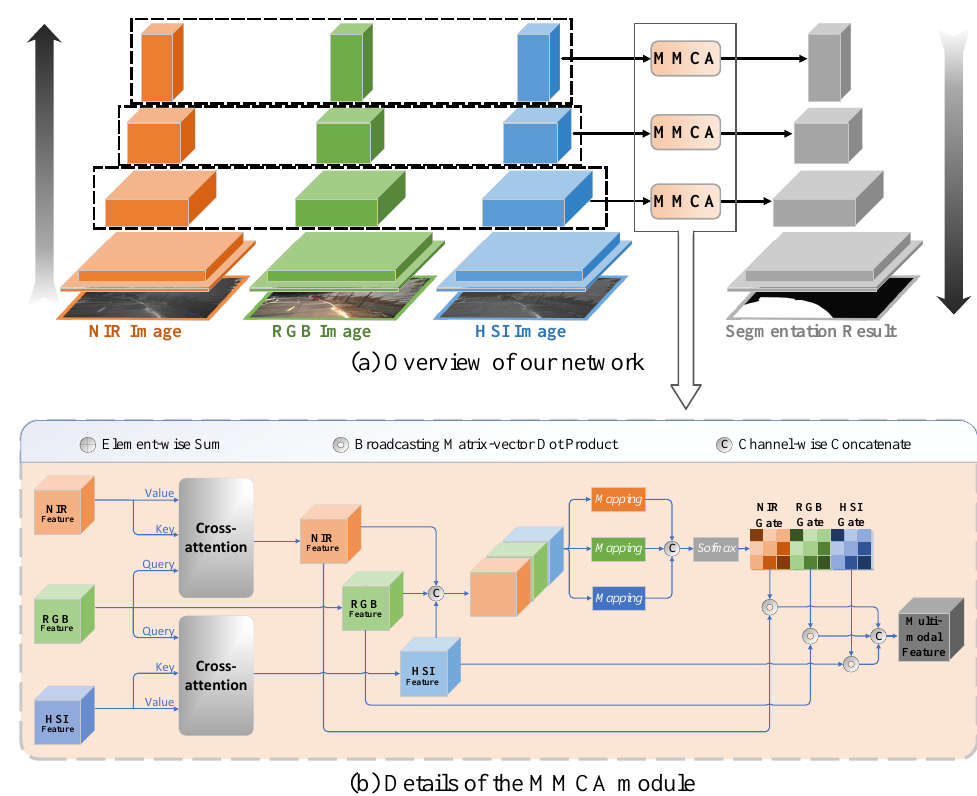
Figure 2. ( a ) Pipeline of the proposed segmentation network. An encoder-decoder architecture is employed. The input of the network is a group of RGB, HSI, and NIR images. They are processed by three encoders. In each group, the HSI and NIR features are weighted by the RGB feature separately, then fused by a triplet gate. The fusion result is propagated to a U-shape segmentation decoder for the final prediction. ( b ) Details of MMCA, including the implementation of two multi-modal cross-attention blocks and a triplet gate-fusion